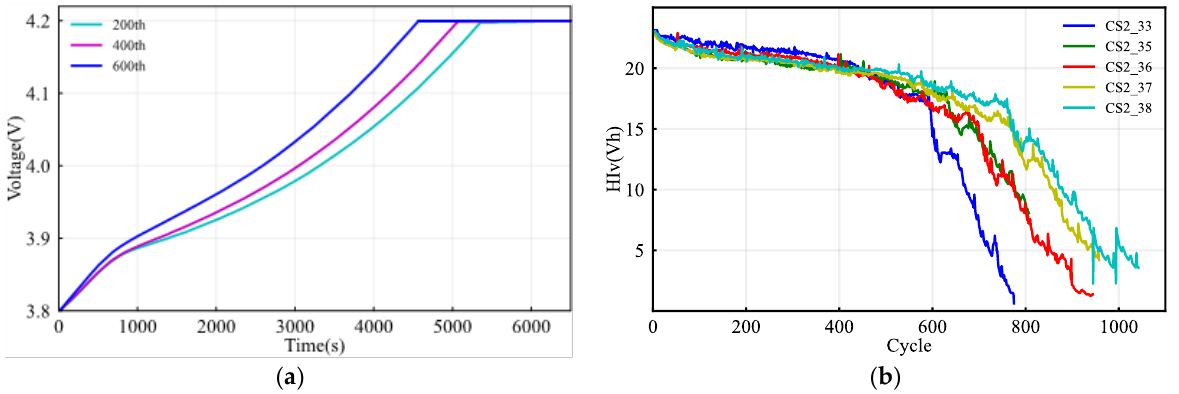
Figure 5. ( a ) Charge voltage curves from 3.8 V to 4.2 V during three different cycles for the CS2-35 battery; ( b ) the curves of the values of the health indicator ( HI v ) versus the cycle number for the CALCE battery dataset.